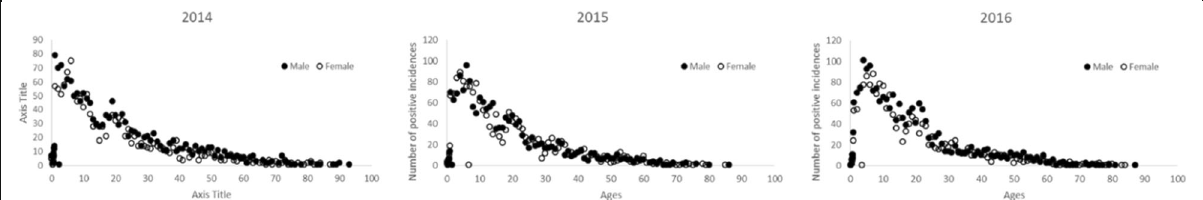
Table 2 Bandwidth value under normal smoothing